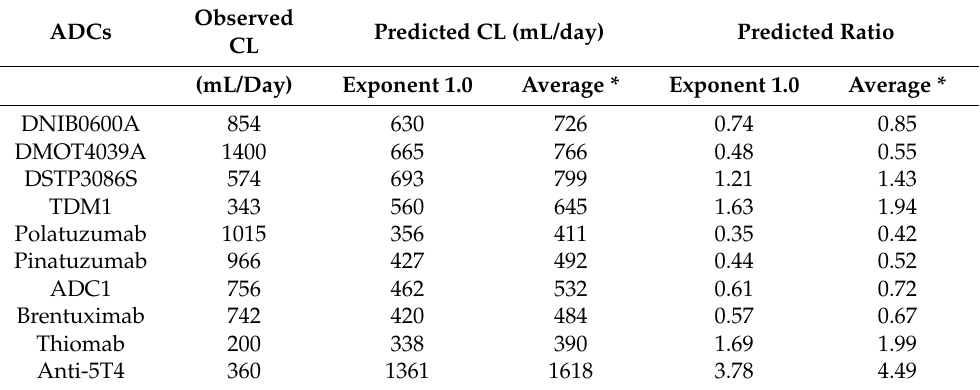
Table 6. Predicted human clearance (total antibody) from mouse using two different methods.